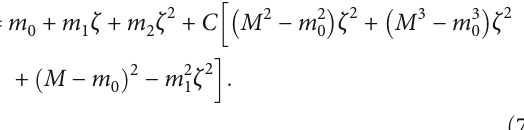
= 2, a = 3, δ = 3, c = 1, a = 2, b = 5 . 0 1